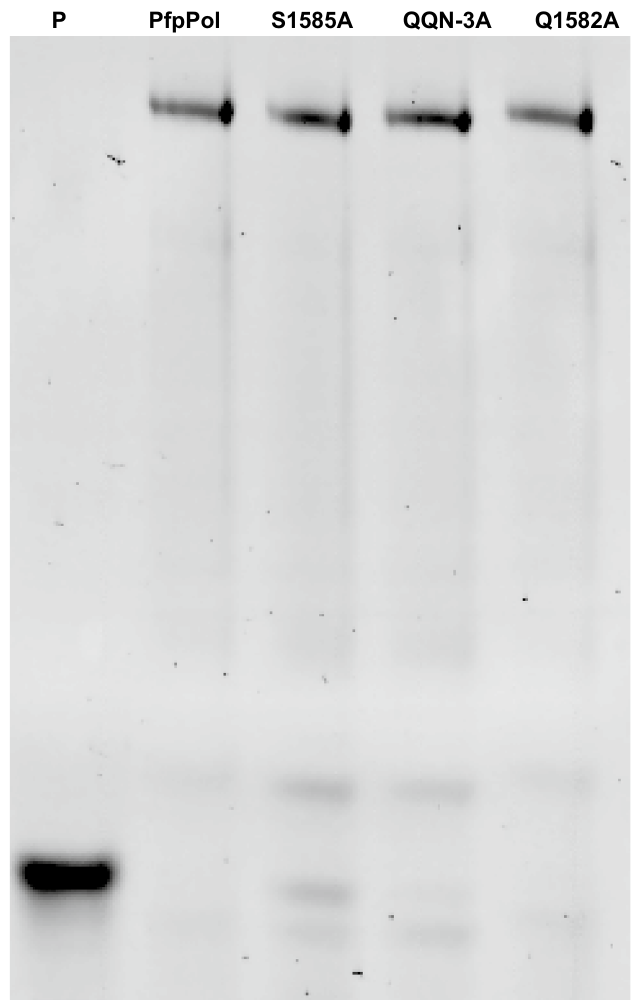
Figure 6. Primer extension activity. The DNA polymerase activity of S1585A, QQN-3A, and Q1582A were compared to that of PfpPol using primer extension assay. 20 nM of each of the protein was incubated with 100 nM of dA DNA substrate and 5 µM of dNTPs for 2 h at 37 °C and resolved on denaturing urea PAGE gel. S1585A, QQN-3A, and Q1582A were able to extend the primer to the same extent as PfpPol. P represents the DNA substrate alone. dA denotes the DNA substrate used in the